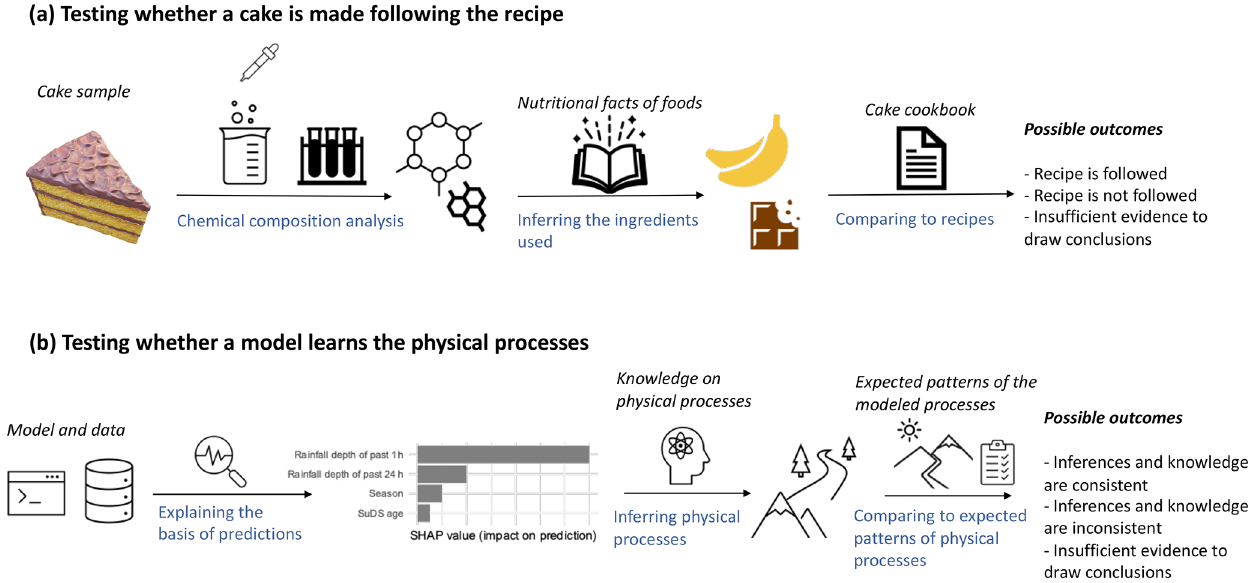
Figure 10. Illustration of the processes of (a) testing whether a cake is made following the desired recipe and (b) testing whether a model captures the physical processes of the system being